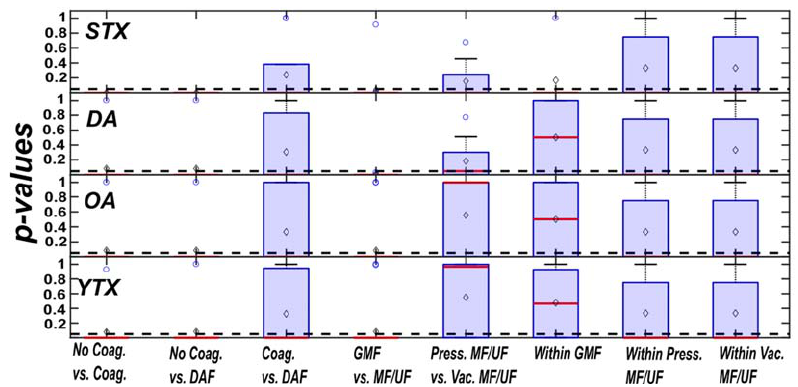
Figure 4. Box and whisker plots of p ‐ values summarizing the Tukey post hoc comparison tests for the permeate waters categorized by each toxin (i.e. STX, DA, OA, YTX). The black dashed lines illustrate the significance level (0.05), while the red lines and black diamonds indicate the median and mean of p ‐ values for each group, respectively. Open circles represent outlying p ‐ values from each comparison group.